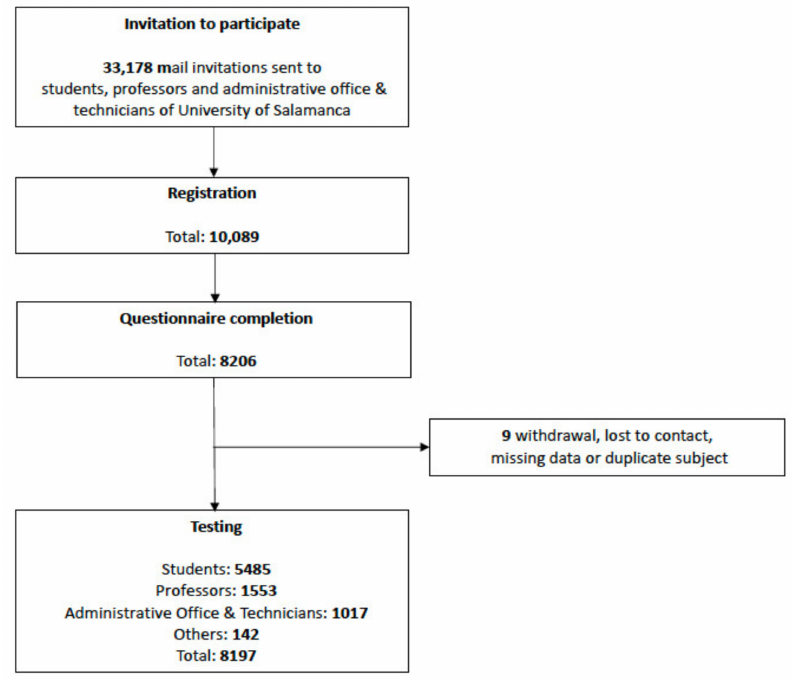
Figure 1. Participant flowchart through the recruitment process with eligibility screening, question- naire completion and